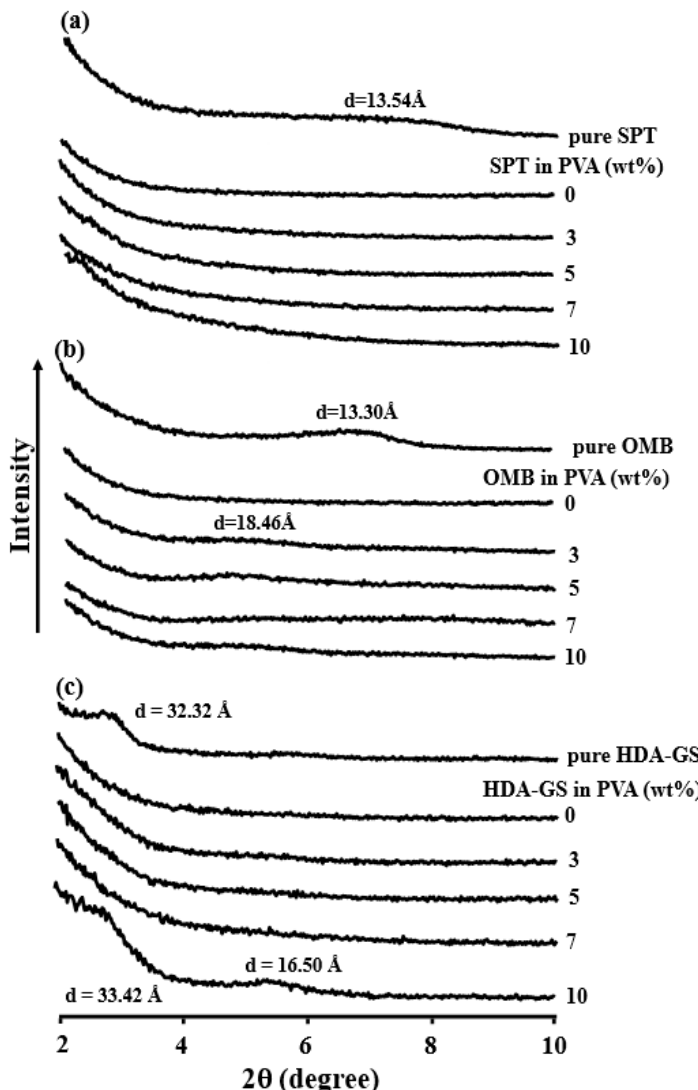
Figure 4. XRD patterns of pristine clay and PVA hybrid films with various nanofiller contents: ( a ) SPT, ( b ) OMB, and ( c ) HDA-GS in PVA.